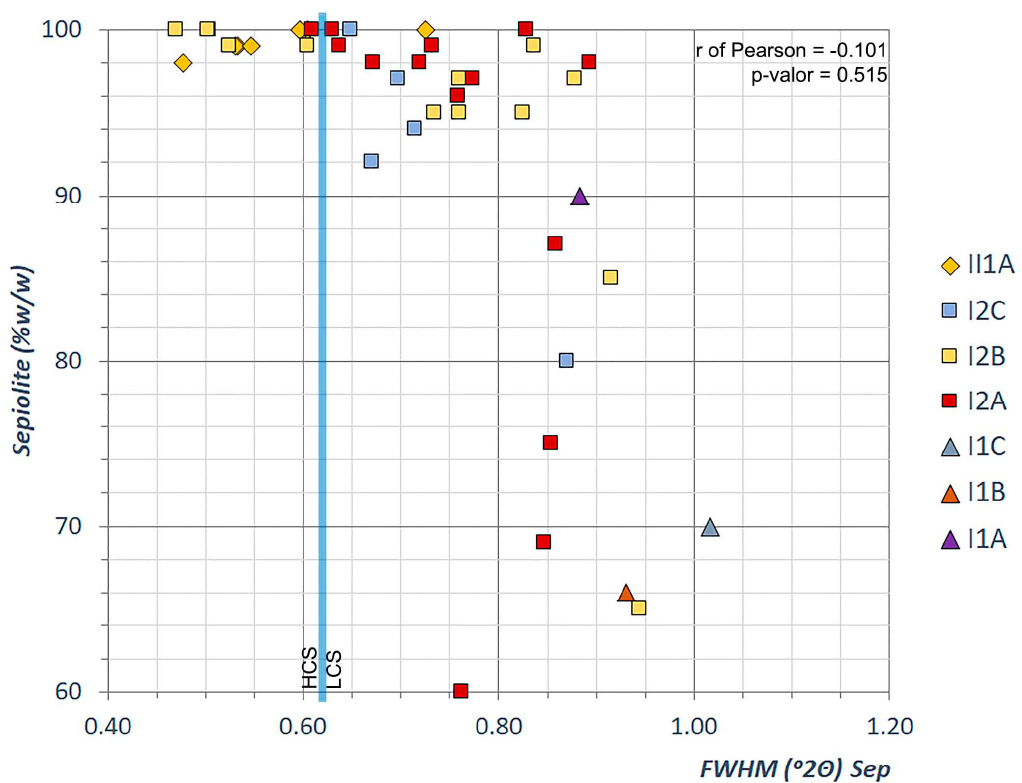
Figure 11. Bivariate plot showing the distribution of sepiolite content vs sepiolite “crystallinity” (FWHM). The blue line separates low “crystallinity sepiolite” (LCS) from high “crystallinity” sepiolite (HCS).